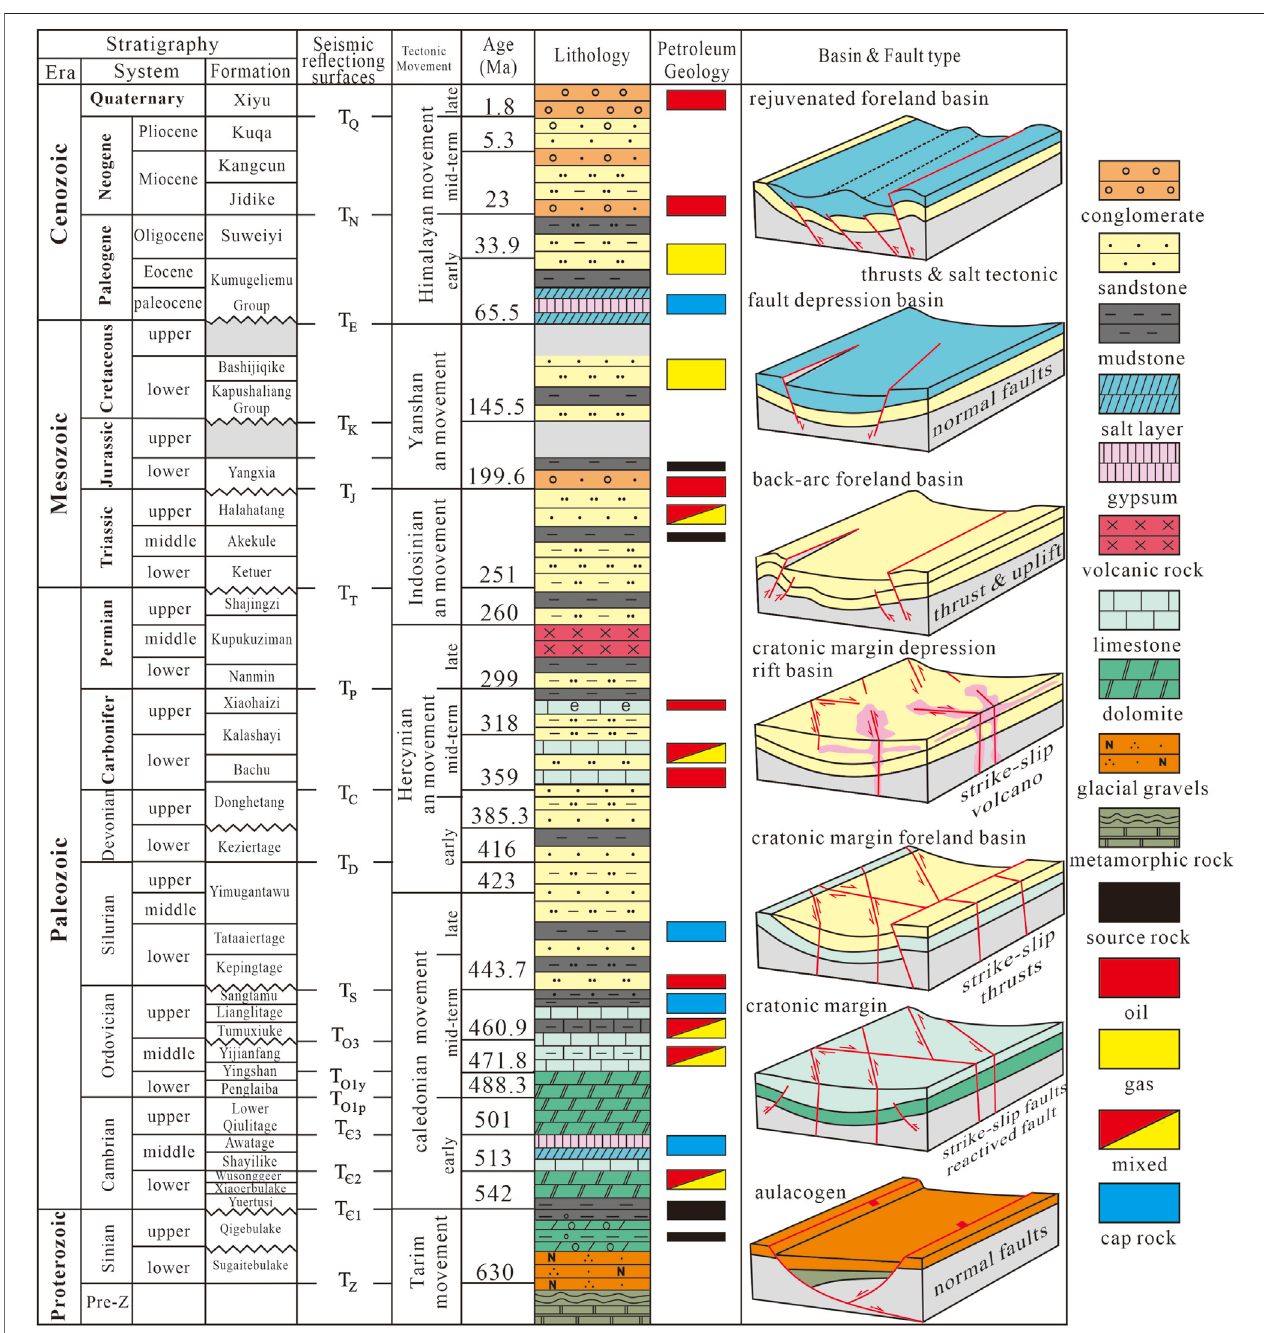
FIGURE 2 | Stratigraphical chart of the Tarim Basin. Seismic data re fl ecting surfaces, tectonic movements, petroleum geology, basin, and fault types in different periods are shown (modi fi ed from Yu et al., 2014; Deng et al., 2019).